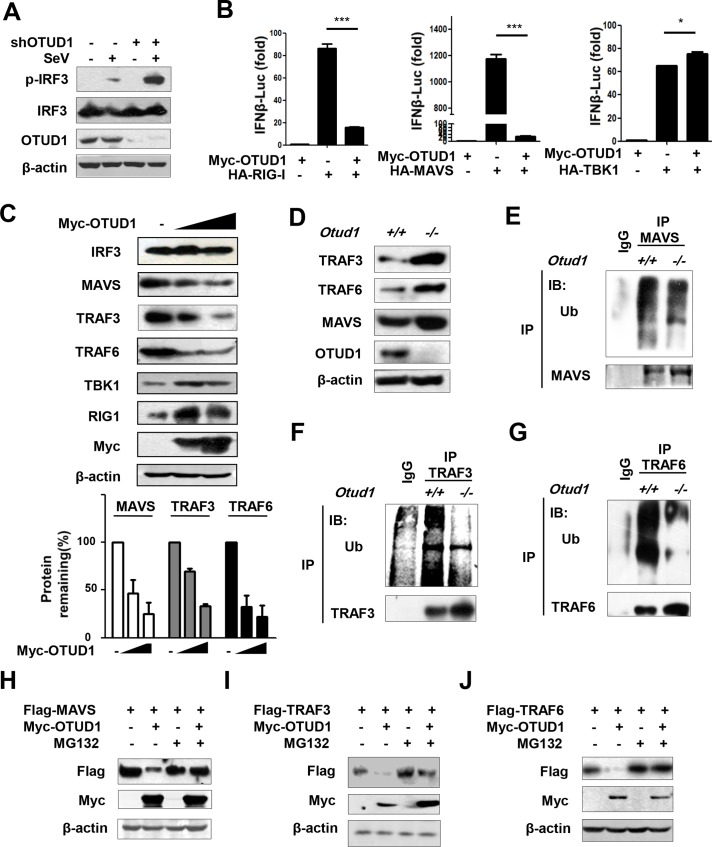
OTUD1 negatively regulates protein levels of MAVS, TRAF3, and TRAF6.(A) Immunoblot analysis of phosphorylated IRF3 (p-IRF3) in HeLa cells transfected with shRNAs plasmids (shCON or shOTUD1), and then infected with SeV for 12 hr. (B) HEK293T cells were transfected with vector or Flag-OTUD1, together with HA-RIG1, or HA-MAVS, or HA-TBK1. The IFNβ luciferase activity was analyzed after SeV infection. The data were shown as fold change normalized to that in cells without HA-RIG1/MAVS/TBK1. (C) HEK293T cells were transfected with increasing amounts of Myc-OTUD1. The levels of indicated proteins were analyzed by immunoblotting. The densitometry of the proteins (MAVS, TRAF3 and TRAF6) is presented relative to those of β–actin, and quantification of relative protein levels was from three independent experiments. (D) Immunoblot analysis of the indicated proteins in the Otud1+/+ or Otud1-/- primary MEFs. (E-G) MAVS, TRAF3 and TRAF6 were immunoprecipitated from whole cell lysates of Otud1+/+ or Otud1-/- MEFs. Ubiquitination levels of MAVS (E), TRAF3 (F) and TRAF6 (G) were detected by immunoblotting by a specific Ub antibody. (H-J) HEK293T cells were transfected with Myc-OTUD1, together with Flag-MAVS (H), or Flag-TRAF3 (I), or Flag-TRAF6 (J). Cells were either untreated or pretreated with MG132 (20 μM) for 4 hr before the harvest. The levels of Flag-MAVS (H), Flag-TRAF3 (I) and Flag-TRAF6 (J) were detected by immunoblotting as indicated. *P<0.05, **P<0.01 and ***P<0.001 (unpaired t-test). Data are representative of three independent experiments.